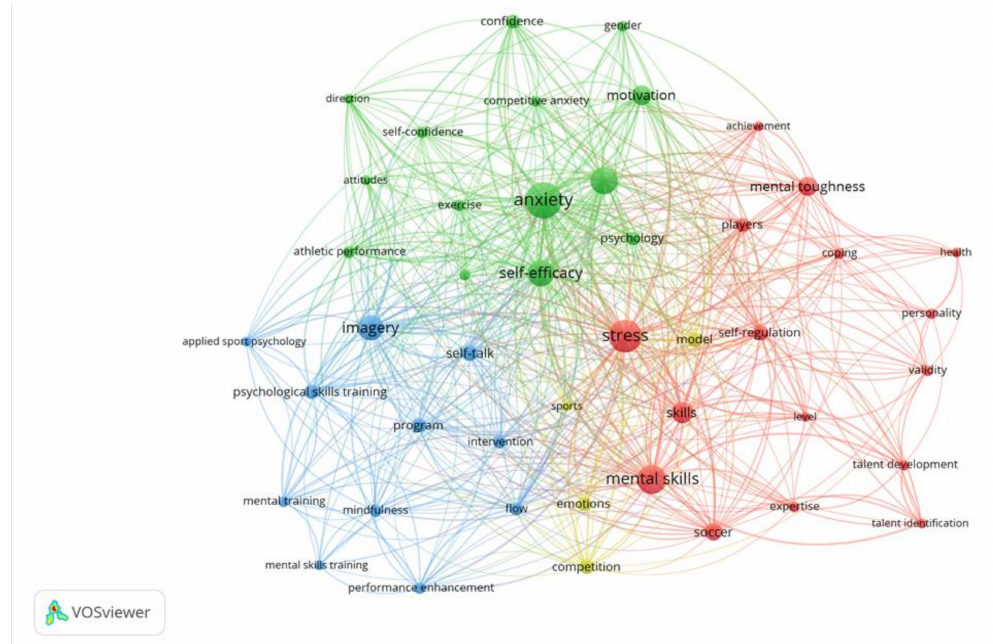
Figure 3. Co-word network created by